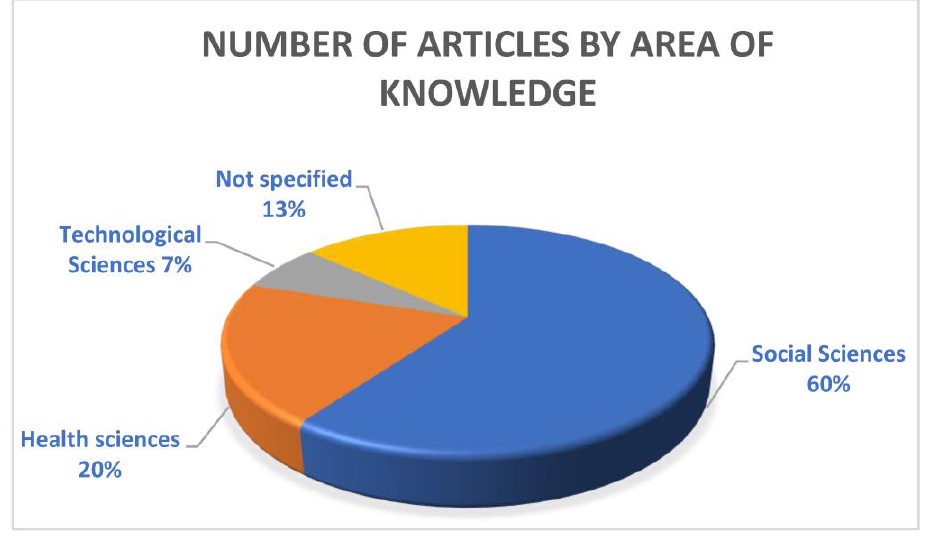
Figure 2. Number of articles by areas of knowledge.